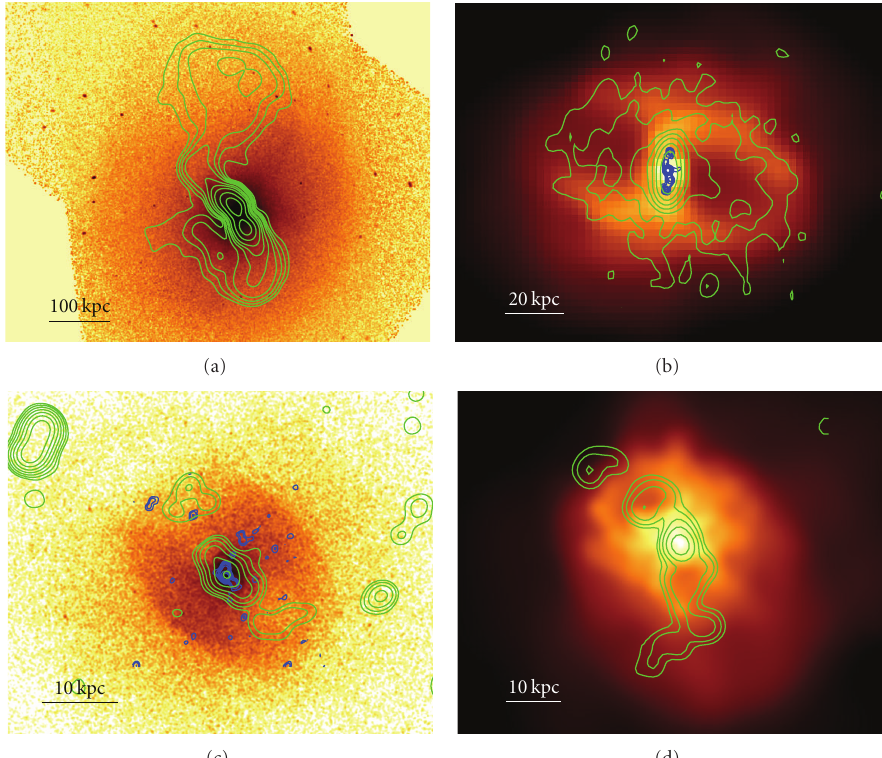
Figure 1: (a) The green contours outlining the 330MHz radio emission from Lane et al. [164] are overlaid onto the 0.5–7.5 keV Chandra image of the galaxy cluster Hydra A ( z = 0 . 0538). The extended radio lobes fill a large-scale system of X-ray cavities and are surrounded by a “cocoon” shock. See also Sections 5.6 and 5.8. adapted from Nulsen et al. [116]. (b) Very Large Array (VLA) radio contours overlaid onto the 0.5–7.0 Chandra image of the galaxy cluster RBS 797 ( z = 0 . 35). The subarsec resolution radio image shows the details of the innermost 4.8GHz radio jets (blue contours), which clearly point in a north-south direction. Remarkably, these inner jets are almost perpendicular to the axis of the 1.4GHz emission observed at 1 (cid:11)(cid:11) resolution (green contours), which is elongated in the northeast-southwest direction filling the X-ray cavities. Adapted from Gitti et al. [130]. (c) 0.3–2 keV Chandra image of the galaxy group NGC 5813 ( z = 0 . 0066) with 1.4 GHz VLA (blue) and 235 MHz Giant Metrewave Radio Telescope (green) radio contours overlaid. The image shows two pairs of cavities, plus an outer cavity to the northeast, two sharp edges to the northwest and southeast, and bright rims around the pair of inner cavities. Adapted from Randall et al. [157]. (d) 235MHz GMRT contours overlaid on the smoothed 0.5–2.0 keV Chandra image of the compact group HCG 62 ( z = 0 . 0137). The radio source shows a disturbed morphology with inner lobes clearly filling the well-defined X-ray cavities, but with outer lobes having no associated X-ray cavities (see also Section 5.4). Adapted from Gitti et al. [153].